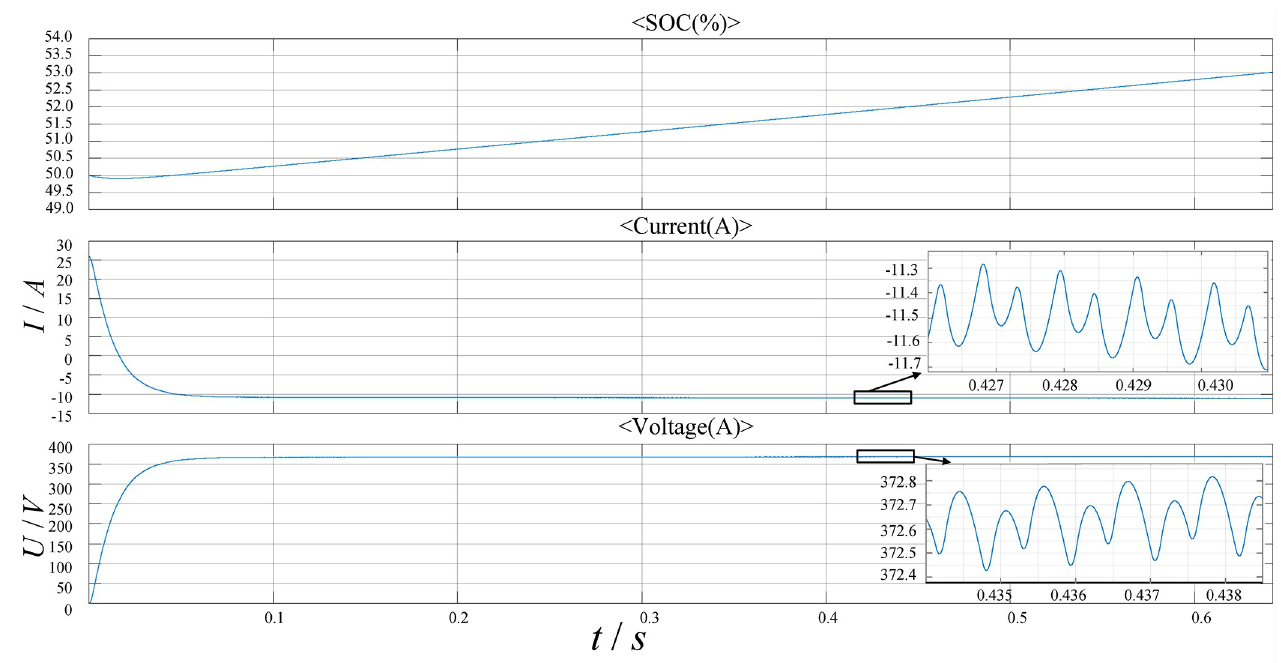
Fig 23. The charging process of the high voltage power battery.